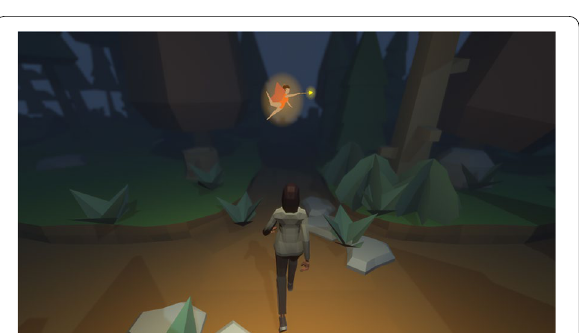
Fig. 2 Stop-signal game. Participants had to navigate a character through an enchanted forest. At each intersection, after a variable inter-trial interval of 500–1500 ms, the fairy at the top of the screen indicated the direction in which the character should turn (here: right turn). An auditory stop-signal was presented on a subset of trials; after a stop-signal, participants were tasked to withhold their